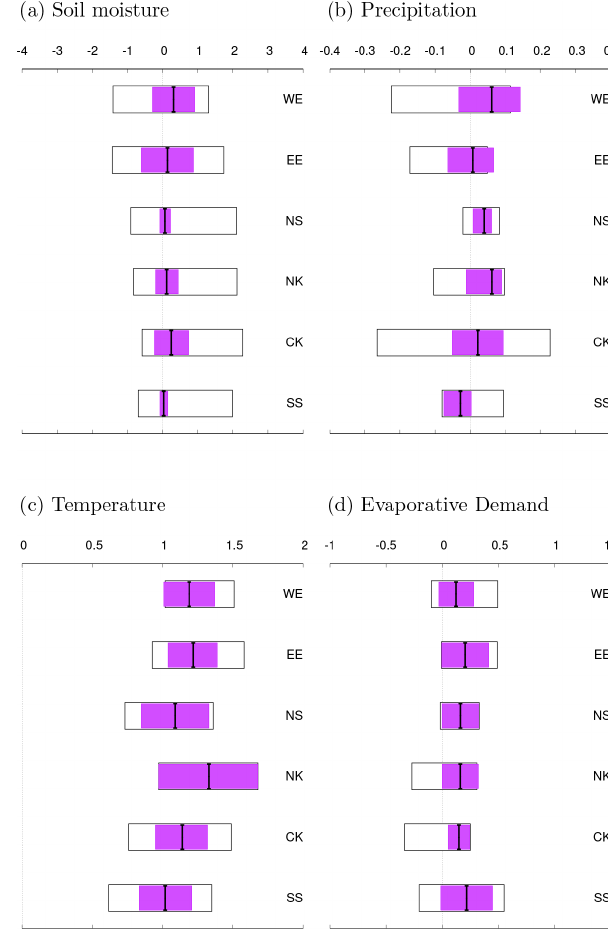
Figure 6. Summary of the synthesized values for (a) soil moisture in [/K], (b) precipitation in [mm/d/K], (c) temperature in [K/K], and (d) E 0 in [mm/d/K] in the six regions. The magenta bars denote the weighted averages of observations and models, and the white boxes denote the unweighted